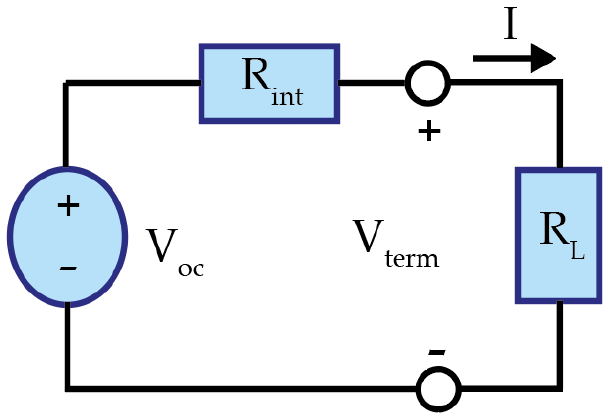
Figure 6. Battery’s Thevenin equivalent circuit.